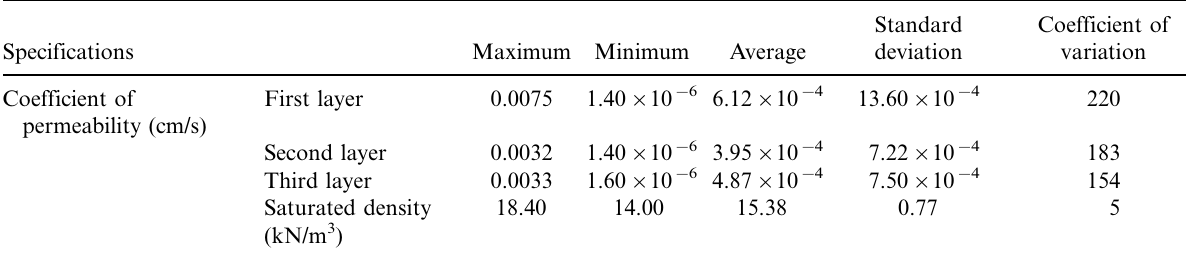
Table 2. Summary of field results Specifications